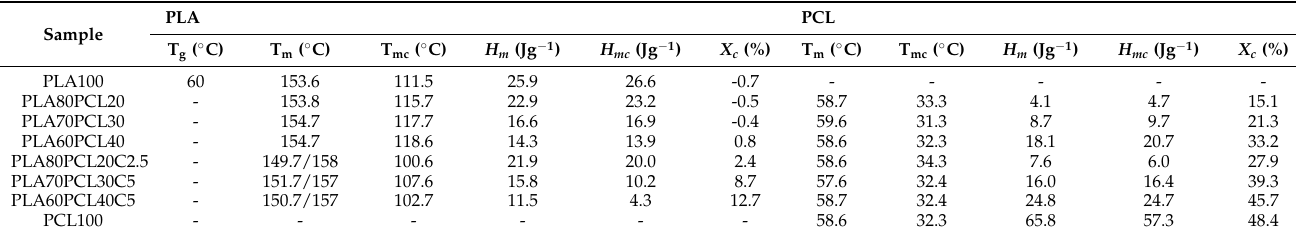
Figure 3. DSC curves of PLA, PCL, PLA/PCL, and blends with additive: ( a ) cooling scans and ( b ) second heating scans. Table 3. Thermal parameters of PLA, PCL, PLA/PCL, and PLA/PCL/ PEG-PPG-PEG